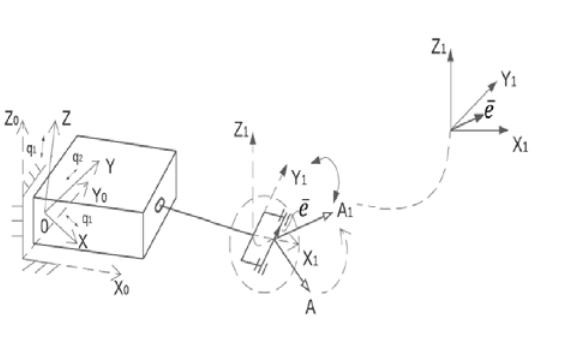
Fig. 1. Deviation of the physical axis of rotation from the ideal position